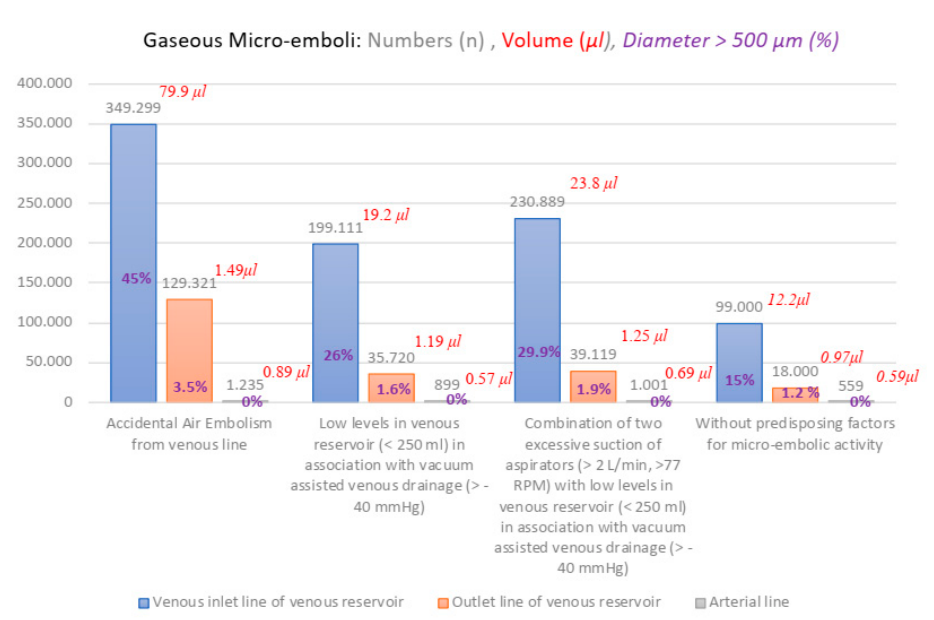
Figure 6. Graphic Representation of gaseous micro-emboli in: Numbers ( n ), Volume ( µ L), Diameter > 500 µ m (%); with and without predisposing factors for micro-embolic activity during Horizon AF PLUS use. Table 1. Preoperative profile and operative data.